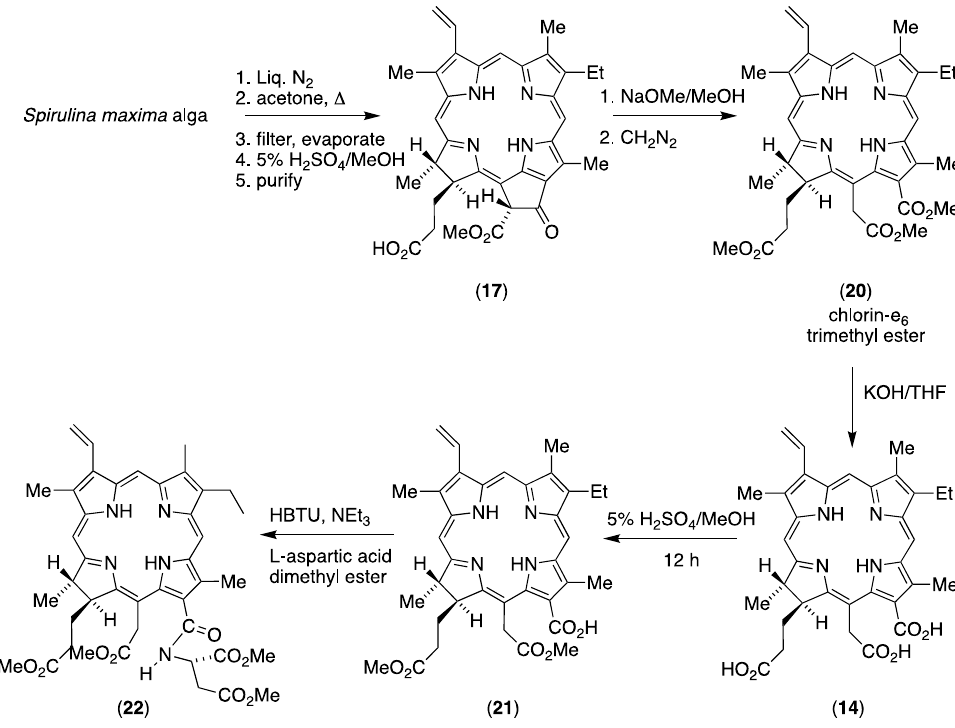
Scheme 2. Synthesis of 13 1 -aspartylchlorin-e 6 tetramethyl ester ( 22